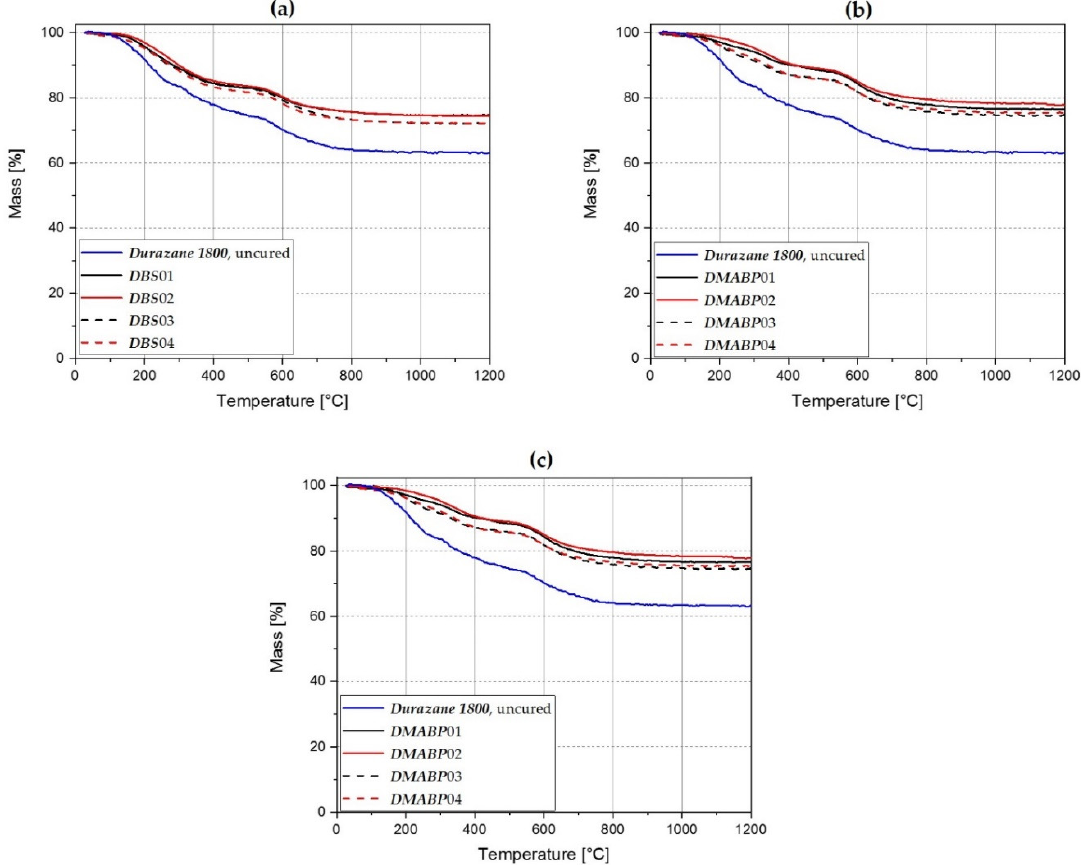
in nitrogen atmosphere.